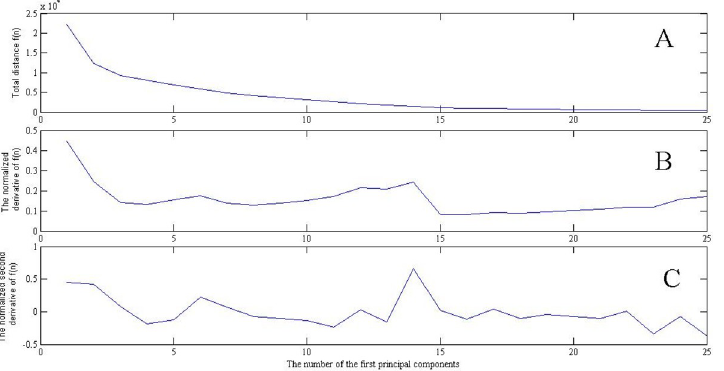
Fig 3. (A) Dependences of the total distance f(n) between all considered sample vectors and multidimensional planes built on the sets of the first n principal components. (B) The normalized derivative of function f(n). (C) The normalized second derivative of f (n). The metagenome contained 15 different genomes; 30 samples were used, in which the genome multiplicities had normal distribution (m, σ ) at m = 10, σ = 3. X axis: the number of the first principal components on which the multidimensional plane is